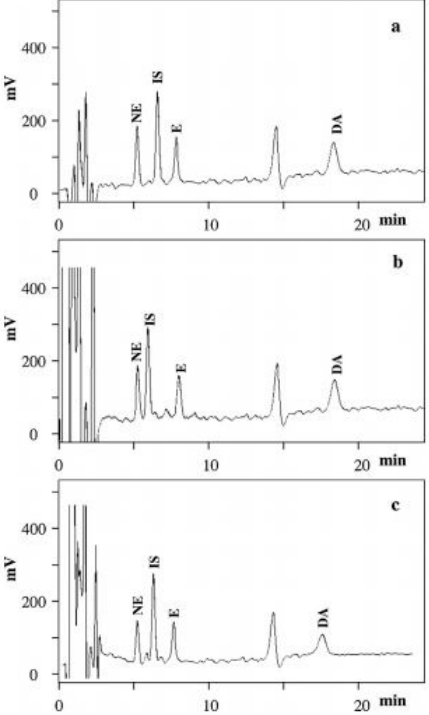
Figure 6. Chromatograms of ( a ) standard solution: ( b ) blank DPS: ( c ) blank DUS. The on-column concentrations were 5 ng/mL for NE, E and DA: 2.5 ng/mL for IS. Figure adopted from reference [71] with the copyright permission.